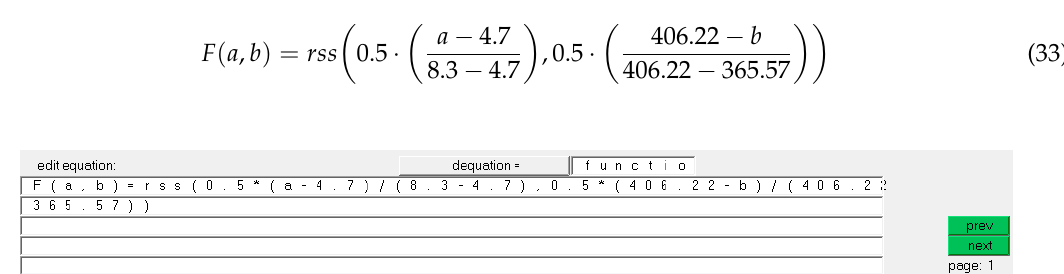
Figure 13. The user-defined integrated multi-objective function.